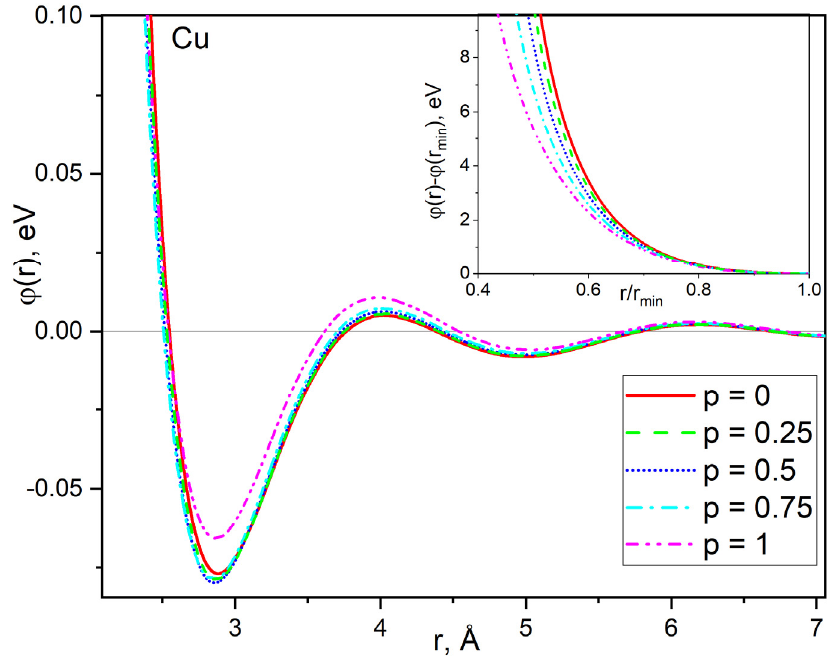
Figure 3. Pair potentials for liquid Cu at T = 1423 K and different p . Inset: the repulsive part of ϕ ( r ) in reduced units.